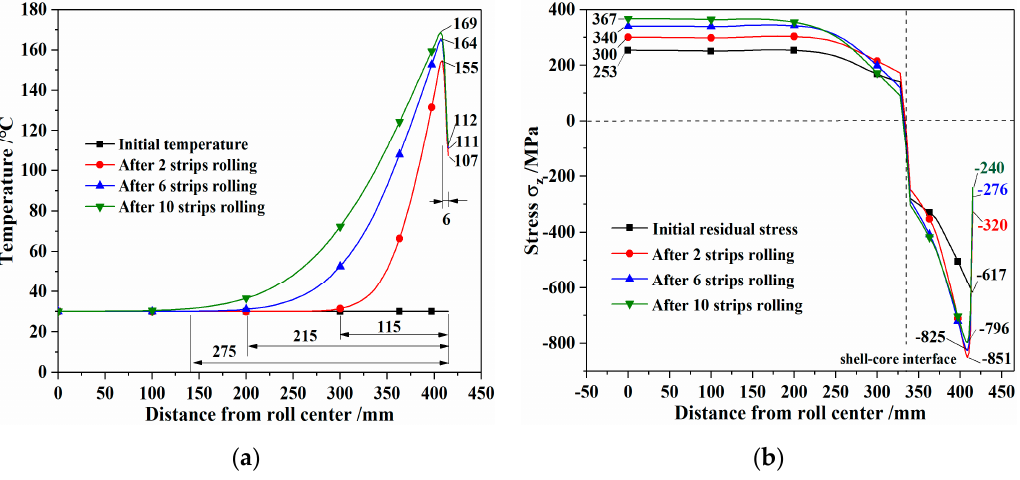
Figure 7. Distributions of temperature and thermal stress considering the initial residual stress in the radial direction of the HSS work roll during hot rolling: ( a ) temperatures after different rolling times; ( b ) thermal stresses after different rolling times.